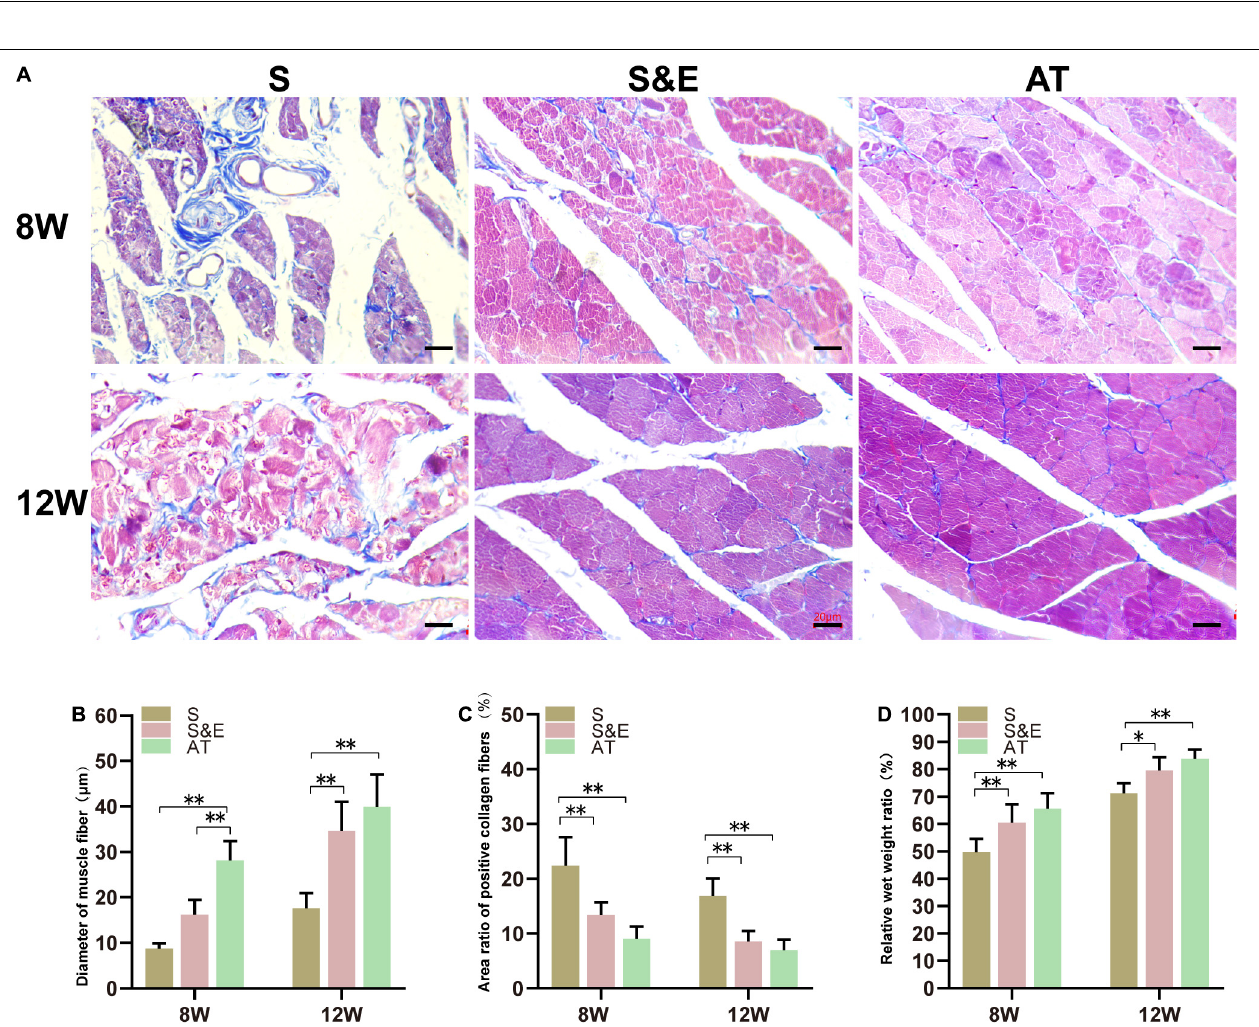
FIGURE 7 | Results of muscle tissues at 8 and 12 weeks after implantation. (A) Masson’s trichrome staining of the gastrocnemius muscle on the experimental side of rats, scale = 20 µ m. (B) Statistical results of muscle fiber diameter ( n = 5). (C) Statistical results of the area ratio of positive collagen fibers ( n = 5). (D) Statistical results of gastrocnemius relative muscle wet weight ratio ( n = 5) ( ∗ p < 0.05, ∗∗ p < 0.01).